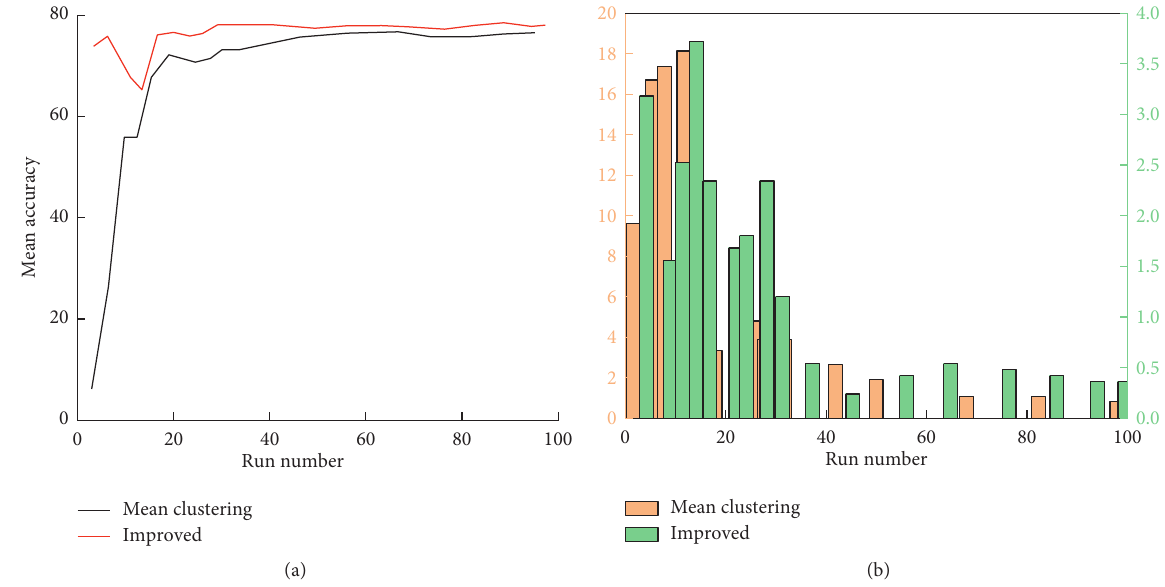
Figure 8: Accuracy variance comparison. (a) Mean accuracy. (b) Overall accuracy.